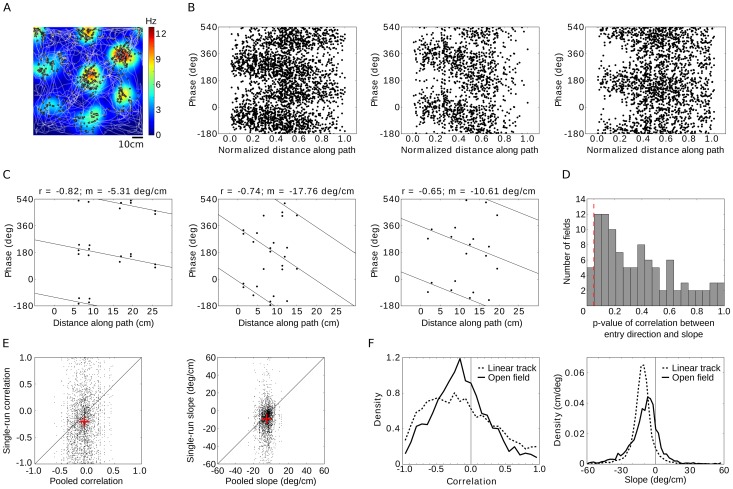
Grid cells exhibit phase precession in two-dimensional environments.(A) Trajectory (white line) of a rat over 10 minutes in a 1 m2 square enclosure together with the firing pattern (black dots) and color-coded firing-rate map of a single grid cell. Data from Sargolini et al. [26]. Note that many different paths traverse each grid field. (B) Spike phase relative to the local field potential for all passages through three example grid fields. Runs with varying directions and originating from various points in the two-dimensional environment are pooled. The position along each path within the firing field is normalized by the path's total length. (C) Three examples of single runs with different phase-precession slopes m and circular-linear correlation values r. Circular-linear regression lines are indicated. (D) Running direction has no consistent influence on the phase-precession slope. Histogram of p-values of the correlation between entry direction of the animal into a firing field and single-run phase-precession slope. The analysis is restricted to straight runs. Red dashed line indicates significance level p = 0.05. (E) Comparison of single-run phase precession and phase precession assessed by pooling all runs through a particular grid field. Each dot represents a single run; the left panel shows the place-phase correlation, the right panel depicts the slope of phase versus location. A negative slope implies phase precession; note the large variability across different runs. Red crosses denote the average correlation and the average slope. The diagonal line marks the identity. (F) Single-run phase precession in one and two-dimensional environments. (left) Distribution of circular-linear correlation values for runs on a linear track (dashed lines) and in the square arena (full lines). (right) Distribution of phase-precession slopes for the same two conditions. Despite the large speed and movement differences between the linear track and the open field, the phase-precession statistics are similar.